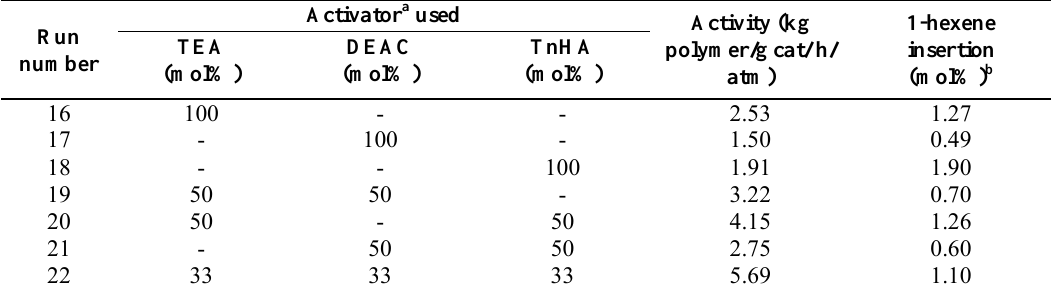
/SiO /TiCl /THF-ZN 2 2 4